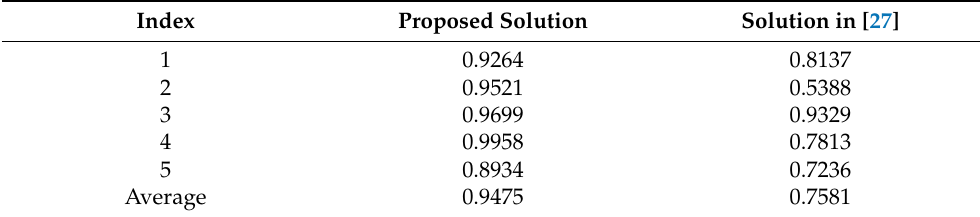
Table 3. CC values between the recovered signals and the corresponding source signals obtained by different methods.